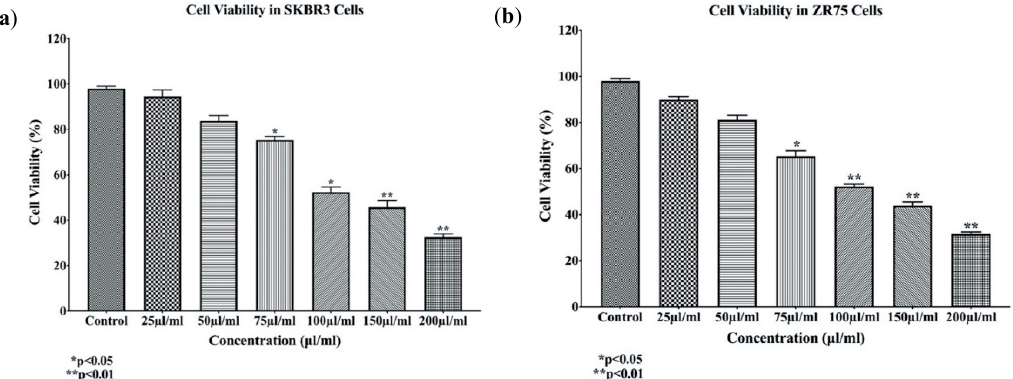
Figure 1. ( a , b ) The effects of different concentrations of Elaeagnus angustifolia (EA) plant extract on cell proliferation of HER2-positive breast cancer cell lines SKBR3 ( a ) and ZR75-1 ( b ) at 48 h. Data indicate an inverse relation between concentrations of EA extract and cell proliferation in both SKBR3 and ZR75-1 cell lines. Data are expressed as percent of growth ± SEM.